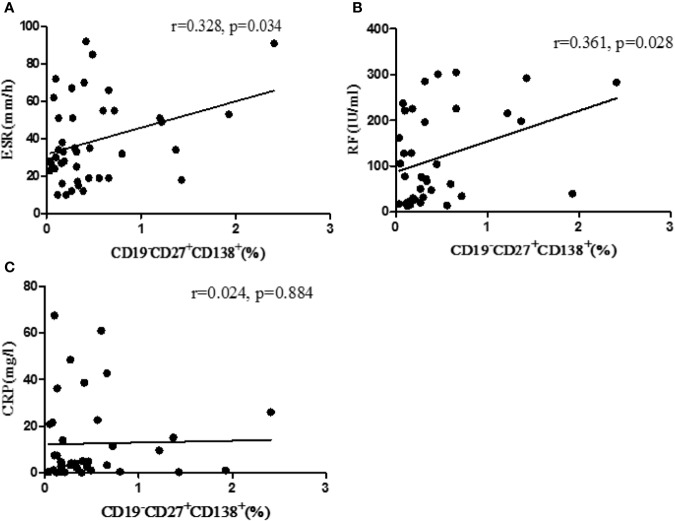
Correlation between the percentage of CD19−CD27+CD138+ B cells and laboratory parameters. (A) The correlation between percentage of B cells with ESR. (B) The correlation between the percentage of B cells with RF. (C) The correlation between the percentage of B cells with CRP. r, correlation coefficient; p, significant level. p < 0.05 indicates statistical significance.